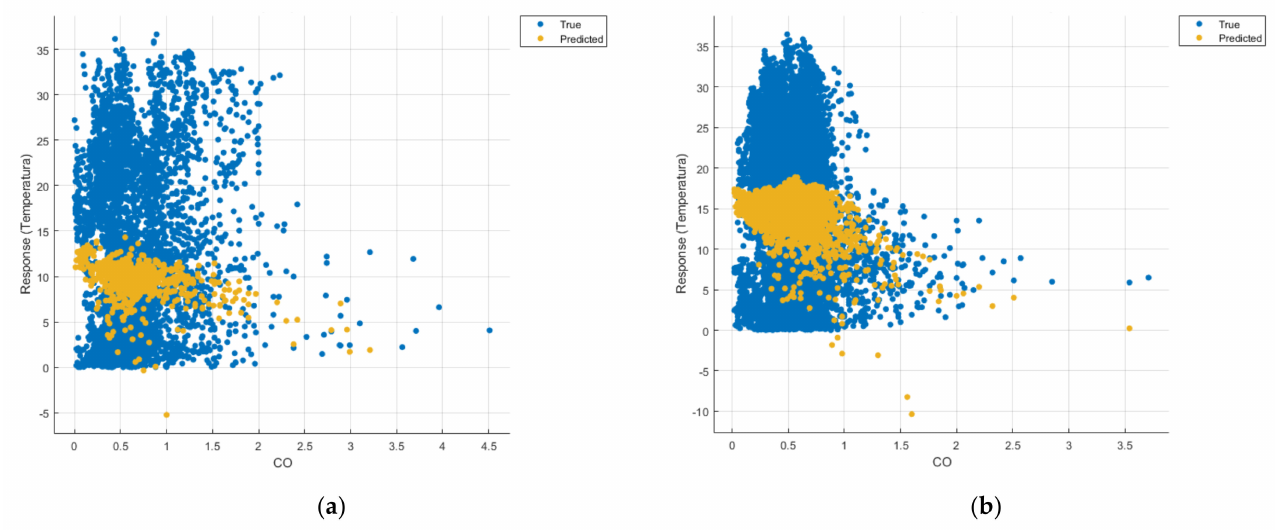
Figure 11. Prediction considering only CO—Linear Regression. ( a ) March 2019–February 2020, ( b ) March 2020– February